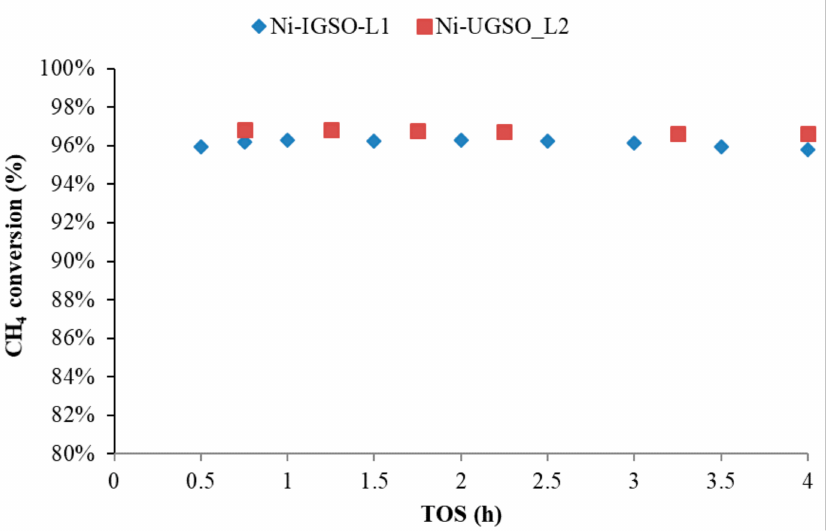
Figure 5. CH4 conversion over TOS at 840 ◦ C, CO 2 /CH 4 = 1.2. Comparison of Ni-UGSO-L1 (batch 1) and Ni-UGSO-L2 (batch 2) calcined at 900 ◦ C for 1